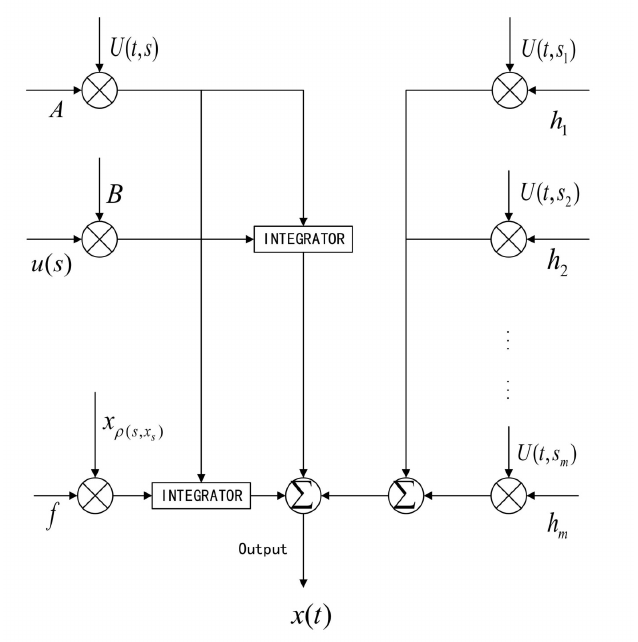
Figure 1. Filter